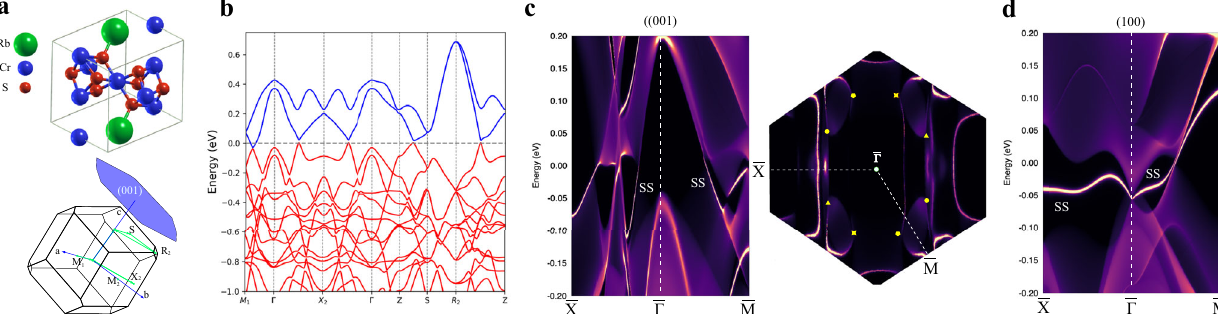
Fig. 4 Smith-index semimetals mp-1238796 Rb(CrS 2 ) 2 with stable invariant η 4I = 3. a The crystal structure and Brillouin zone. b The electronic structure with SOC. The red and blue colors denote the occupied and unoccupied bands, respectively. Panels c and d show the surface states at (001) and (100) surfaces. Rb(CrS 2 ) 2 contains four pairs of Weyl points around the Fermi level within the energy range of ±0.015 eV, which are marked as yellow dots in the E = E F constant energy plot in c . Two Weyl nodes with the same shape are related by inversion symmetry and reside at the same binding